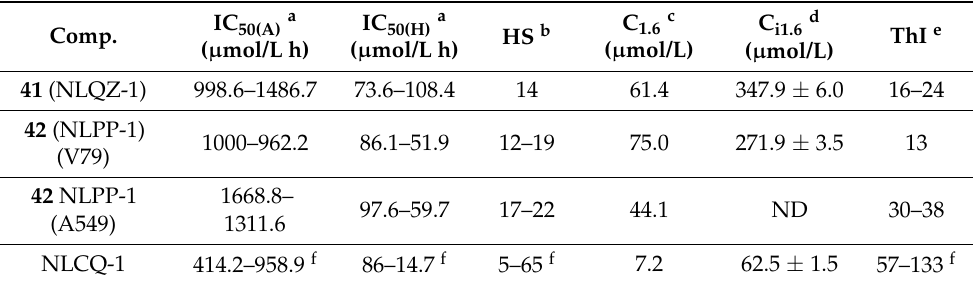
Table 3. Various parameters of the hypoxia-selective cytotoxins 41 (NLQZ-1) and 42 (NLPP-1) and comparison with NLCQ-1 in V79 cells.